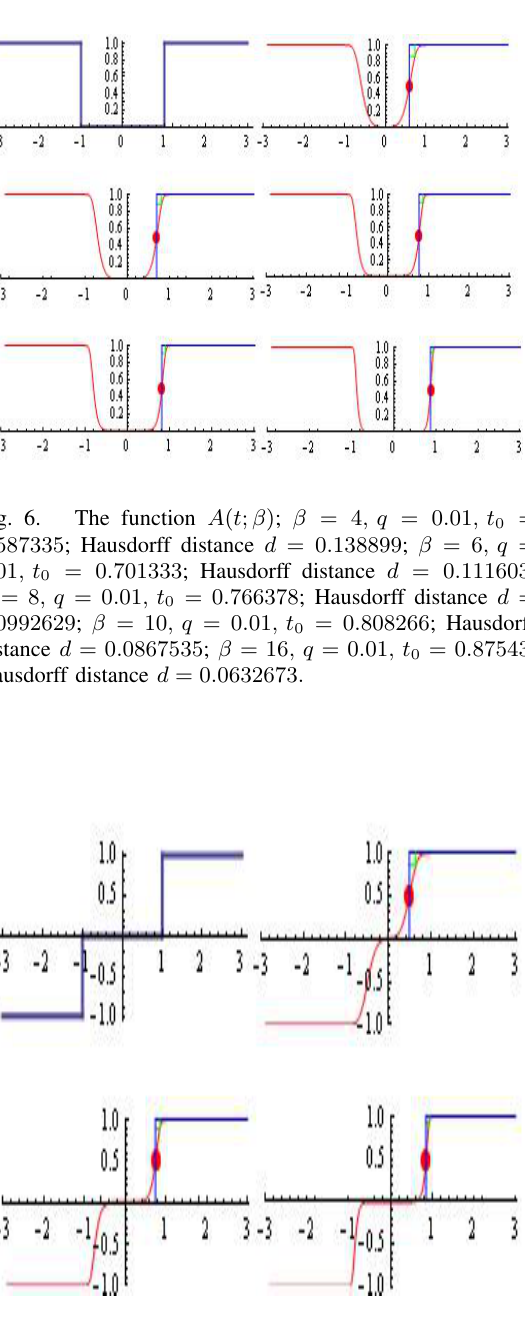
Fig. 7. The function A ( t ; β ) ; β = 3 , q = 0 . 01 , t 0 = 0 . 491867 ; Hausdorff distance d = 0 . 152538 ; β = 7 , q = 0 . 01 , t 0 = 0 . 737794 ; Hausdorff distance d = 0 . 107003 ; β = 13 , q = 0 . 01 , t 0 = 0 . 848962 ; Hausdorff distance d = 0 . 073086 .